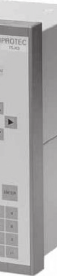
Figure 3: Siemens 7SJ64 numerical relay view.